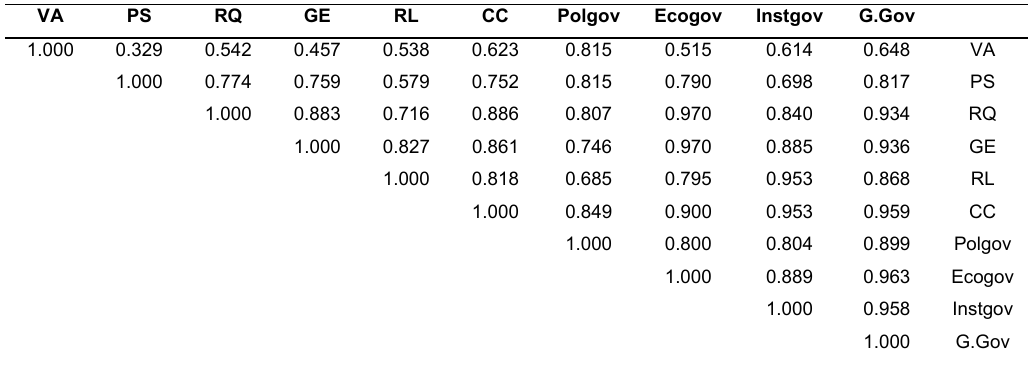
Table 5: Correlation Analysis VA PS RQ GE RL CC Polgov